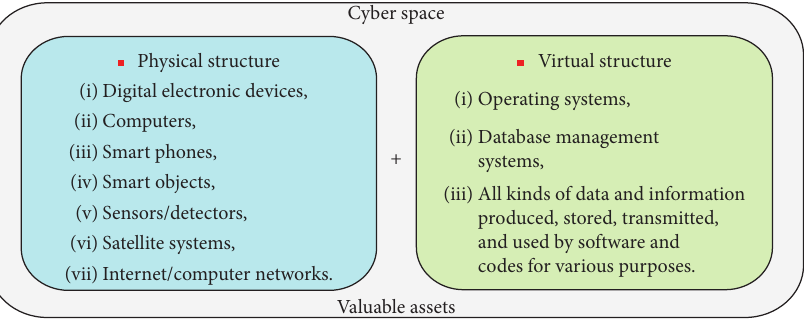
Figure 1: Components of cyber Table 1: Inventory of books, documents, publications, and studies reviewed.